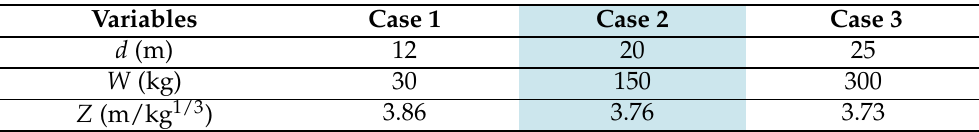
Figure 9. Schematic diagram of the three-story building under study, composed of equally spaced pillars and an outer enclosure wall, including: ( a ) the distances and angles used for the different floor levels ( i = 0, 1, and 2), including the standoff distance, d , the real distance to the midpoint of the different levels, d real, i , and the corresponding angles of incidence, δ real, i ; ( b ) schematic of the façade constructive details and dimensions; and ( c ) diagram of the equivalent façade element used in the SDOF analysis. L i denotes the height of Level i , representing the length of the pillars, and S is the spacing between pillars, representing the tributary loaded width. Table 4. Standoff distance, d , explosive charge, W , and scaled distance, Z , of the different case studies. The reference case is shown in